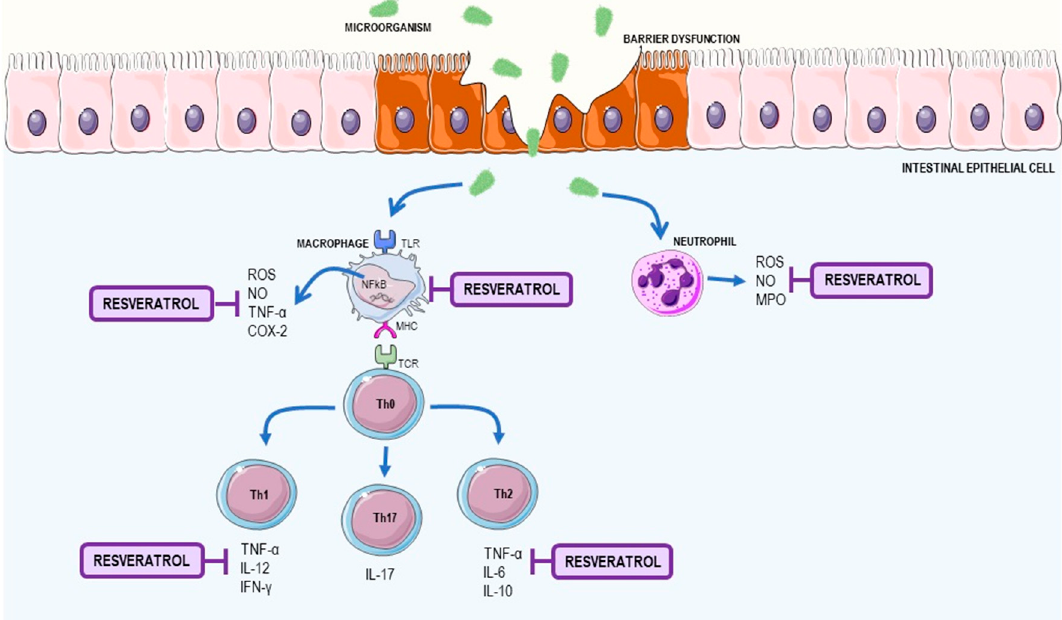
Figure 3. Inflammatory bowel disease (IBD) mechanisms and resveratrol role. IBD develops via a change the intestinal mucosal barrier that leads to a process involving bacterial translocation and subsequent activation of immune cells. The activation of neutrophils and macrophages in the epithelium leads to the production of inflammatory mediators, such as ROS and TNF- α . Antigen recognition by naïve T lymphocytes induces the differentiation to Th1 and Th17 profiles in Crohn’s disease, and to TH2 and Th17 profiles in ulcerative colitis, with the release of inflammatory cytokines, especially TNF- α . Resveratrol is capable of acting on the inhibition of inflammatory cytokines